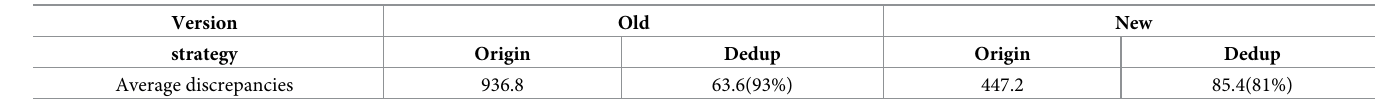
Table 5. The effect of the deduplication strategy on old and new versions.